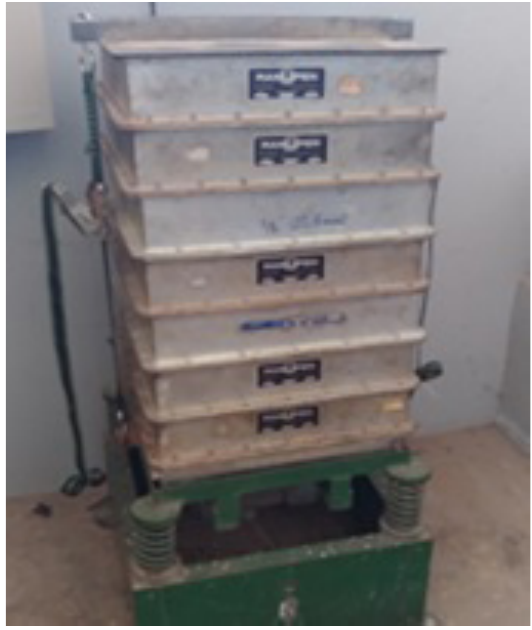
Figure 2. Mesh sieves set.